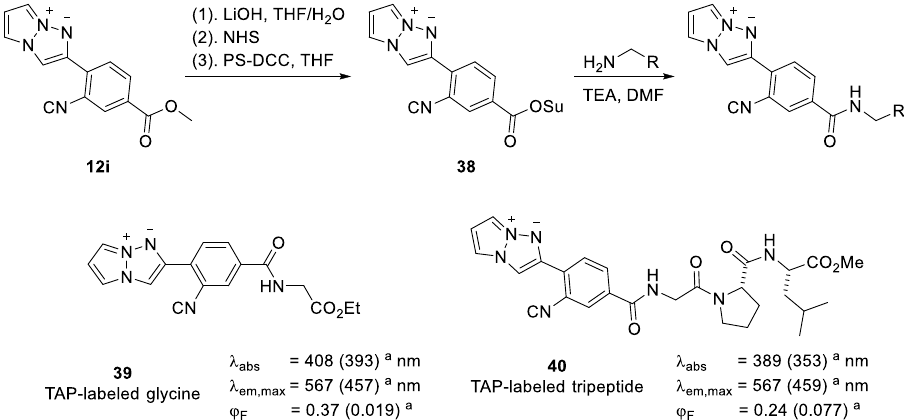
Figure 2. The 2-([1,1’-Biphenyl]-4-yl)-TAP 12e .